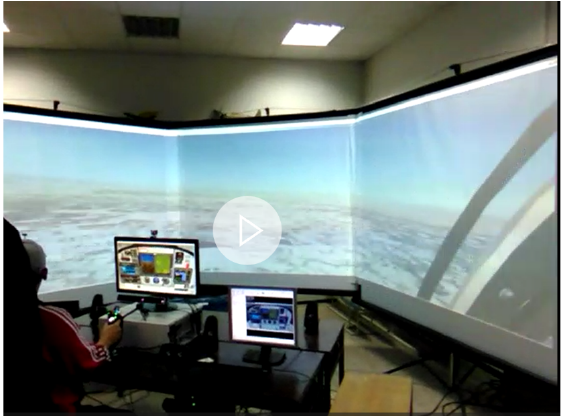
Figure 5. Simulator setup with eye-tracking tool equip-